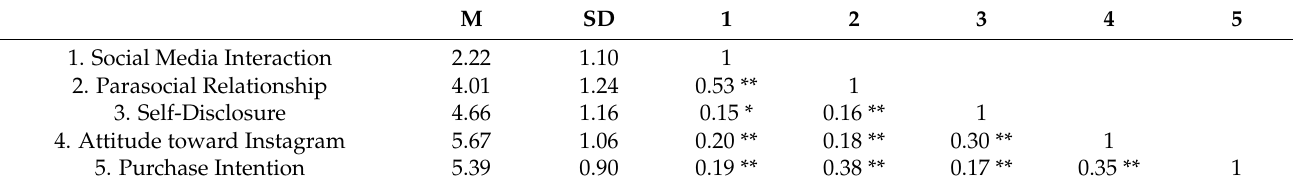
Table 1. Descriptive Statistics and Correlations among